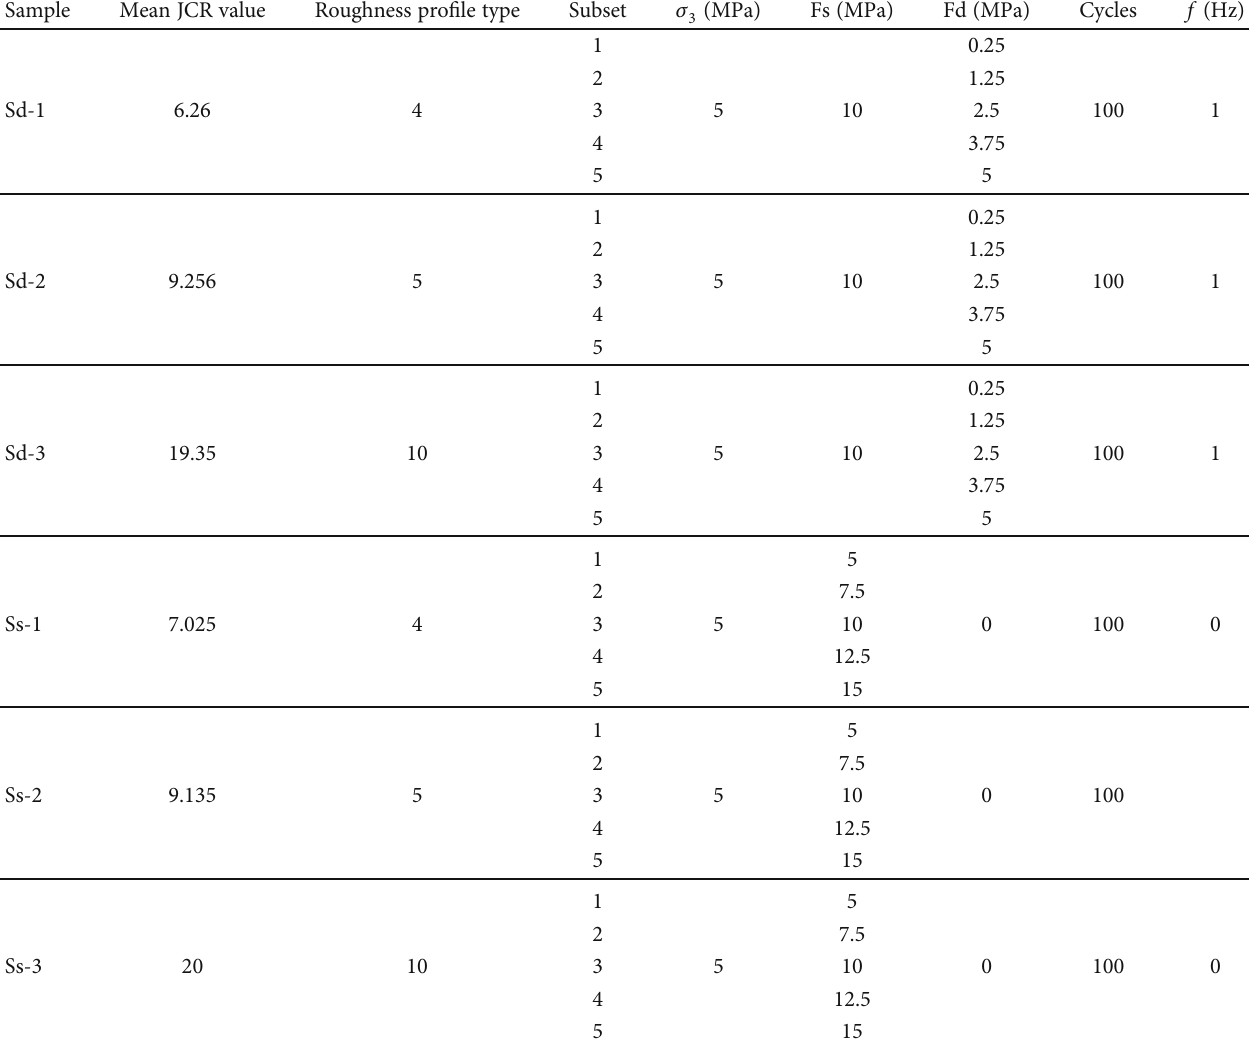
Table 1: Test parameter for stress